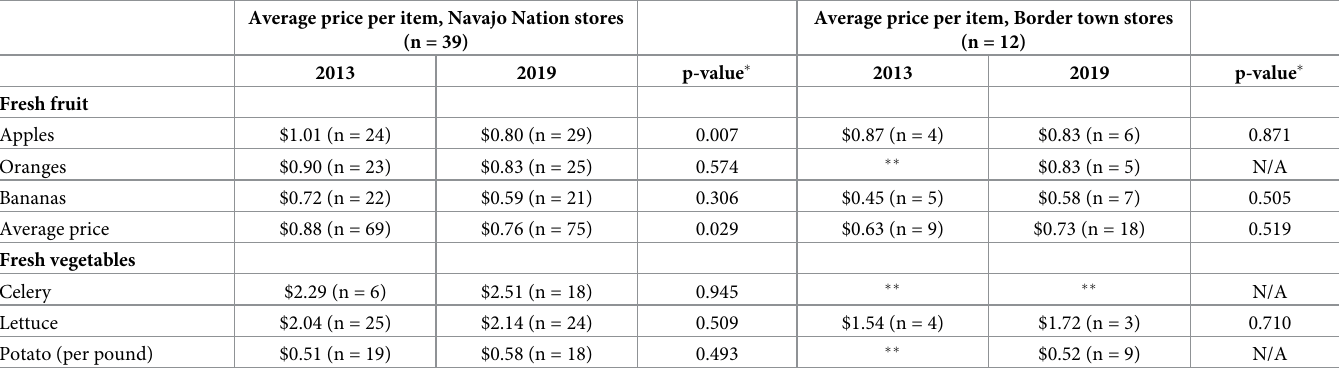
Table 3. Inflation-adjusted average price per item among convenience stores, n = 51.